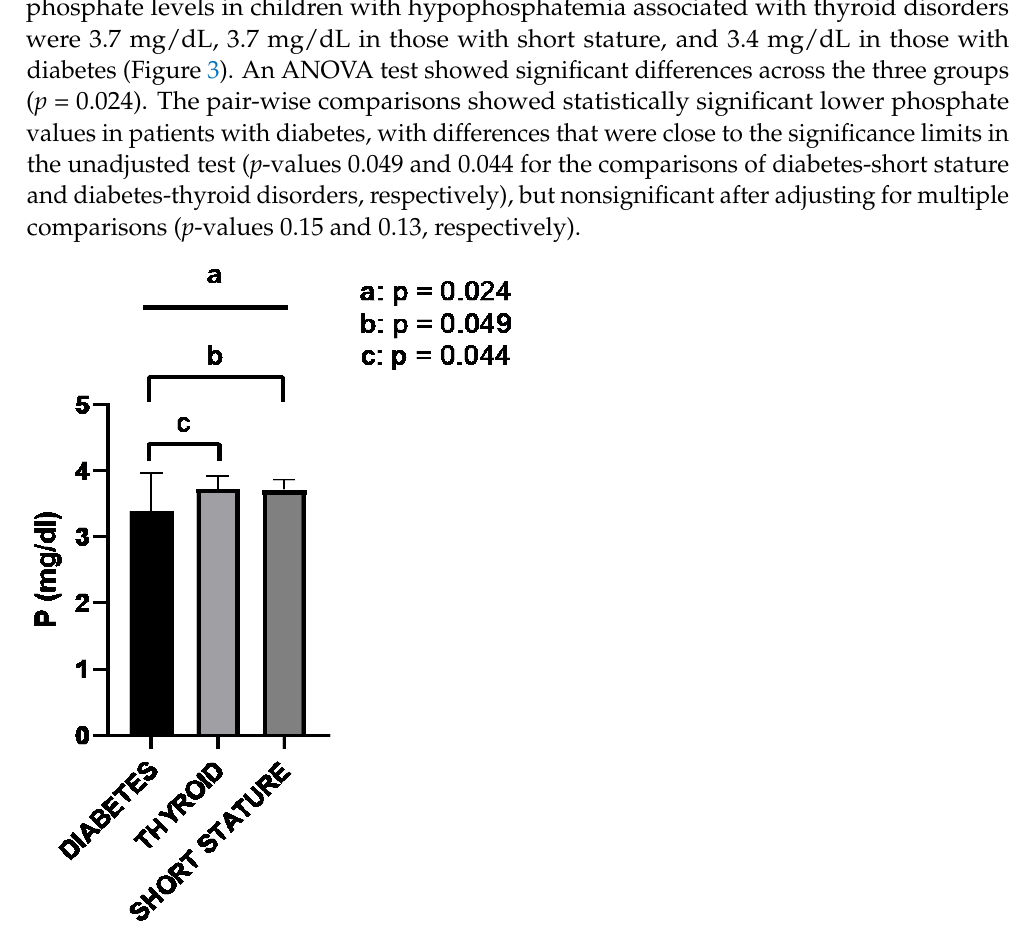
Figure 3. Mean and standard deviation of serum phosphate in children with various endocrine dis- orders.